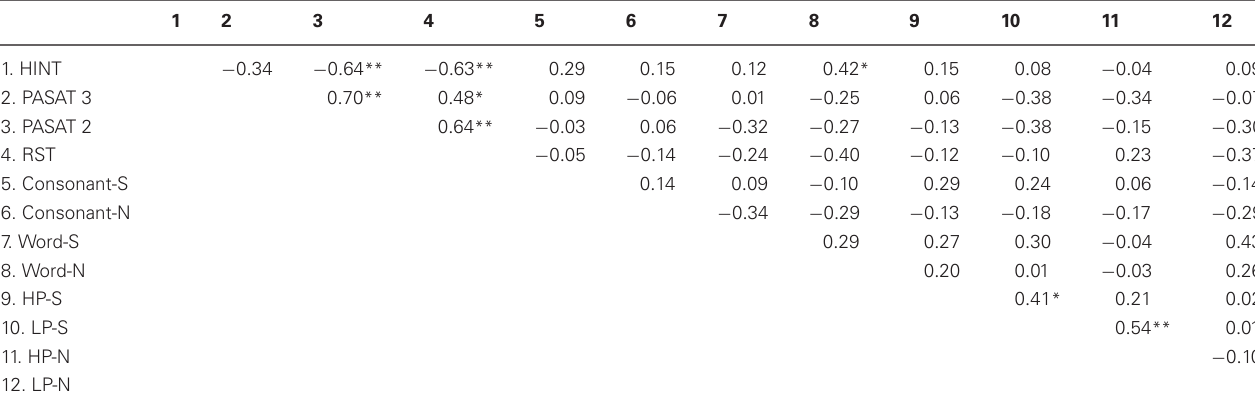
Table 5 | Correlations between IPs for the gated audiovisual speech tasks, the HINT, and the cognitive